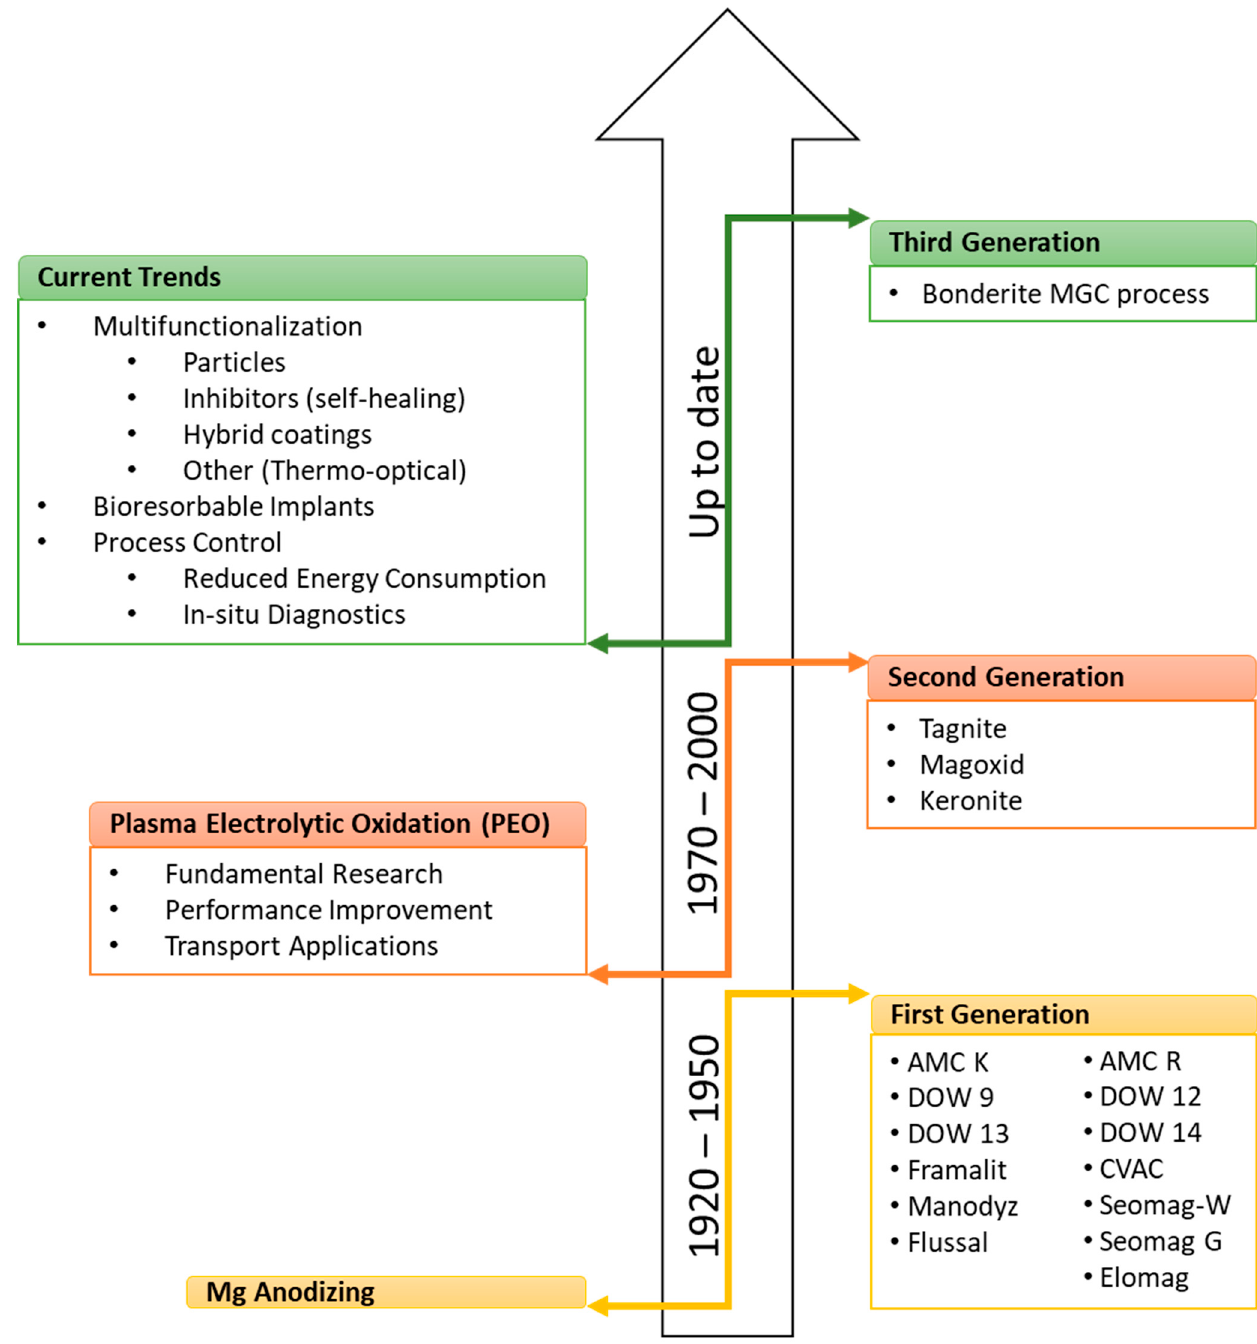
Figure 3. Simplified timeline for the development of PEO coatings on Mg alloys.